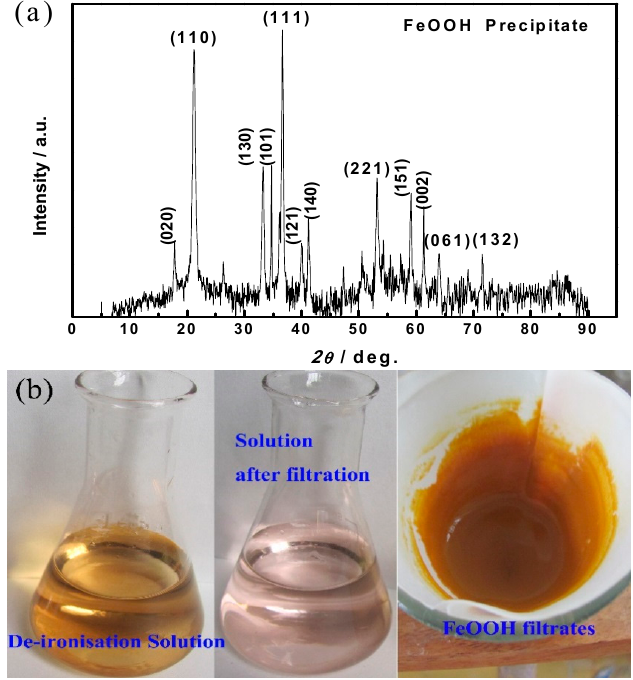
Figure 9. ( a ) XRD patterns of precipitates; and ( b ) photographs of the goethite precipitates.